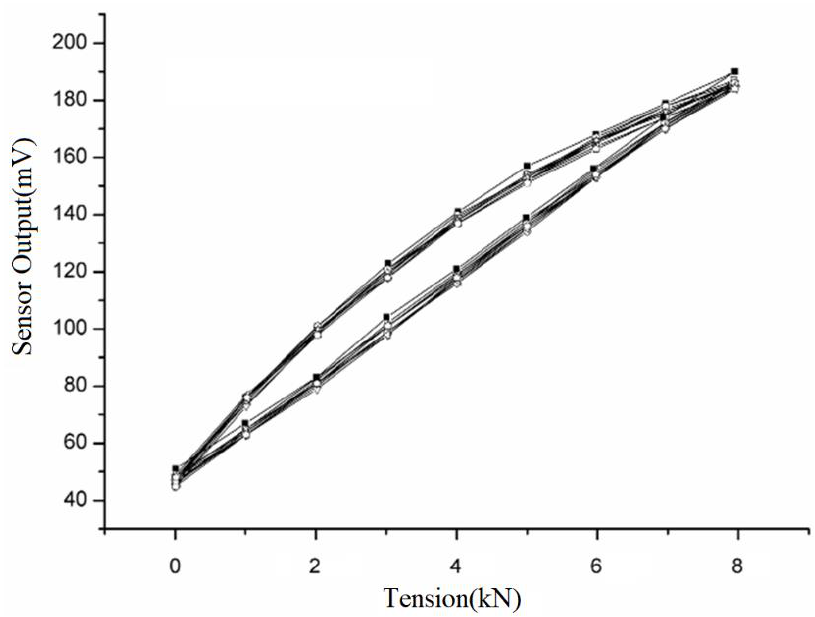
Figure 11. Sense signal change curve with pulling force of 2 mm thick steel plate.